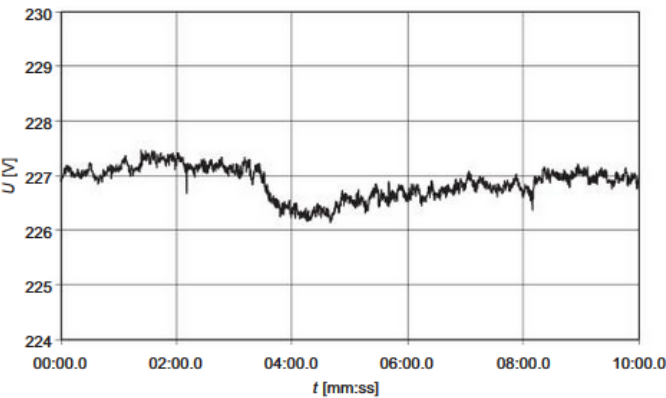
Figure 2. Changes in rms voltage at the terminals of the hydroelectric power plant generator